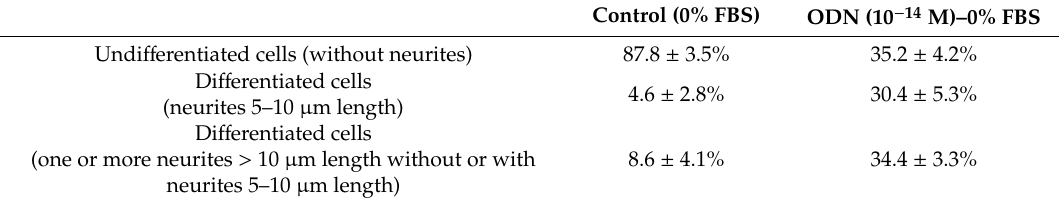
Table 1. Percentages of undi ff erentiated and di ff erentiated N2a cells in control and ODN-treated cells. Murine neuronal N2a cells, previously cultured for 24 h in conventional cultured medium, were further cultured for 48 h in medium without FBS in the absence or presence of octadecaneuropeptide (ODN 10–14 M). In these conditions inducing the highest percentage of di ff erentiation (ODN 10–14 M; 0% FBS) di ff erent types of cells were distinguished: undi ff erentiated cells (without neurites); di ff erentiated cells (neurites 5–10 µ m length); di ff erentiated cells (one or more neurites > 10 µ m without or with neurites 5–10 µ m length). The percentages of undi ff erentiated and di ff erentiated cells were determined; each value are mean ± standard deviation (SD) of 3 independent